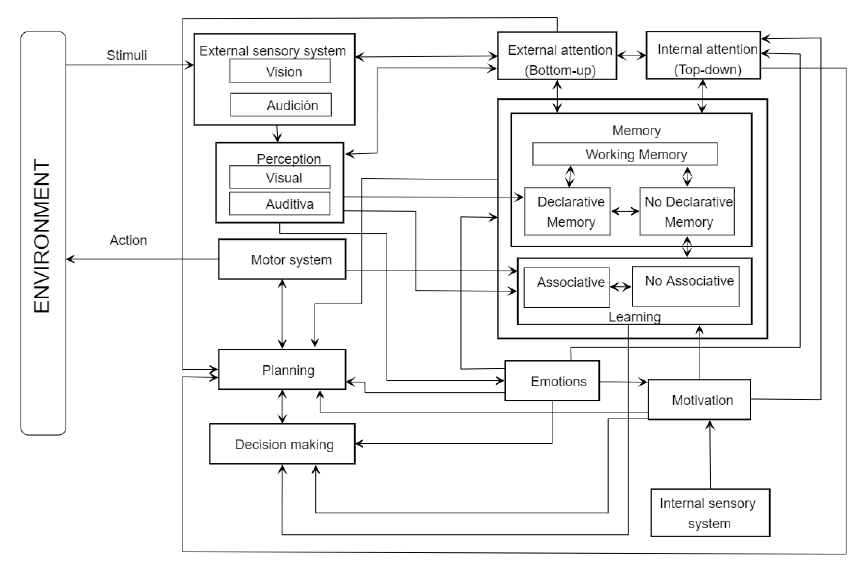
Figure 3. Cognitive functions constituting the Cuâyôllôtl cognitive architecture and their interrelations according to neuroscientific evidence. Each function in this proposal is abstracted as an